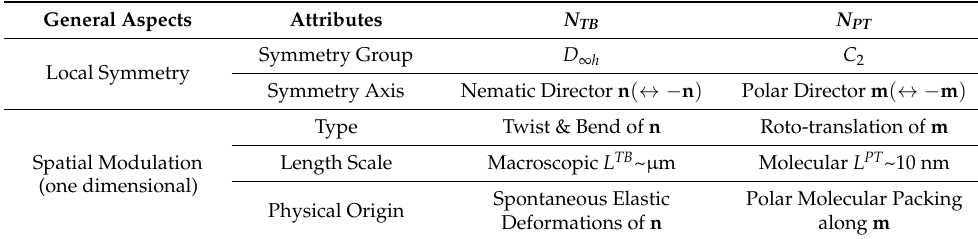
Table 1. Physical characteristics that differentiate the N TB model from the N TP model. General Aspects Attributes Local